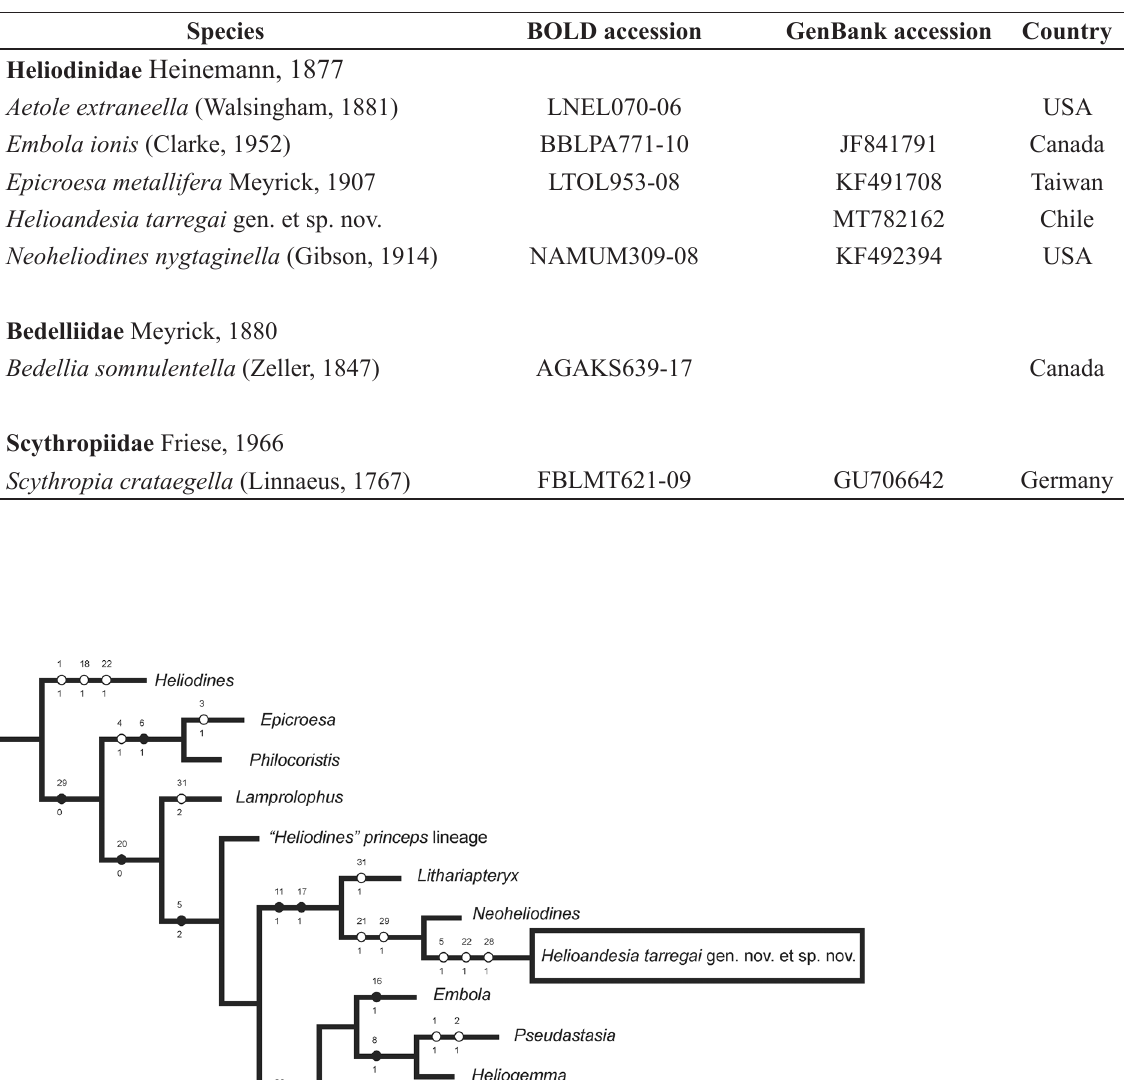
Table 2. DNA barcode sequences used in the molecular